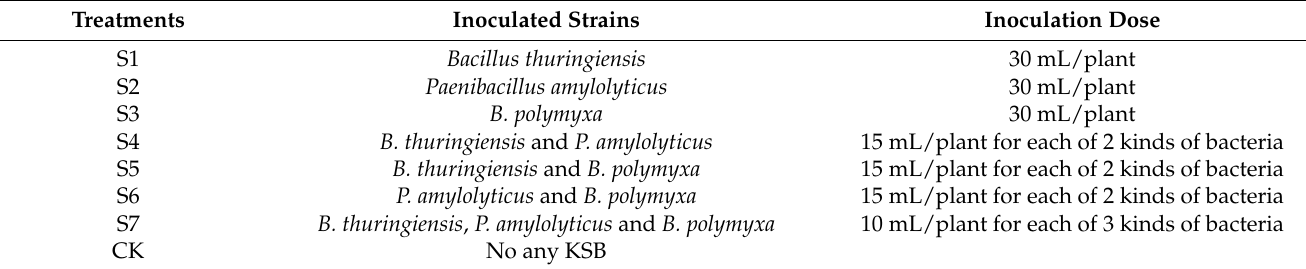
Table 1. Inoculated strains in different